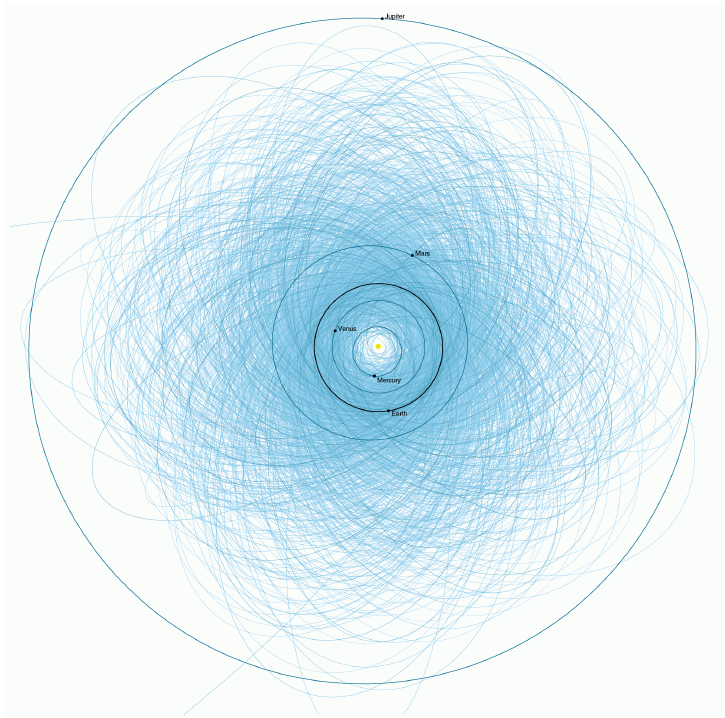
Figure 15. Plot of orbits of known potentially hazardous asteroids with sizes over 140 meters as of early 2013